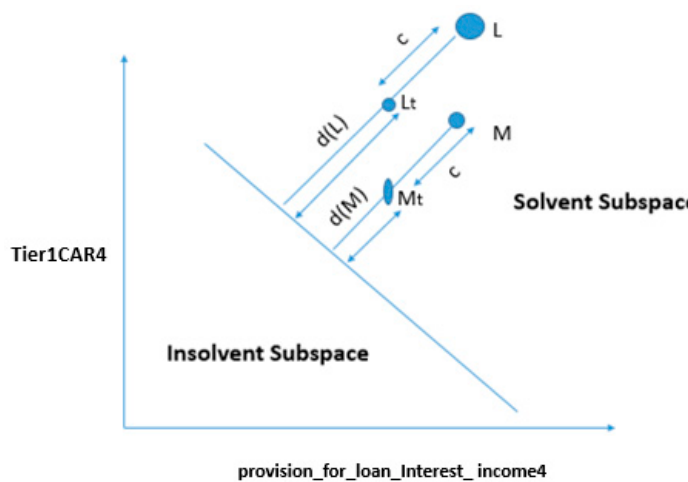
Figure 9. Quantifying and comparing the financial health of surviving banks after the environmental change.